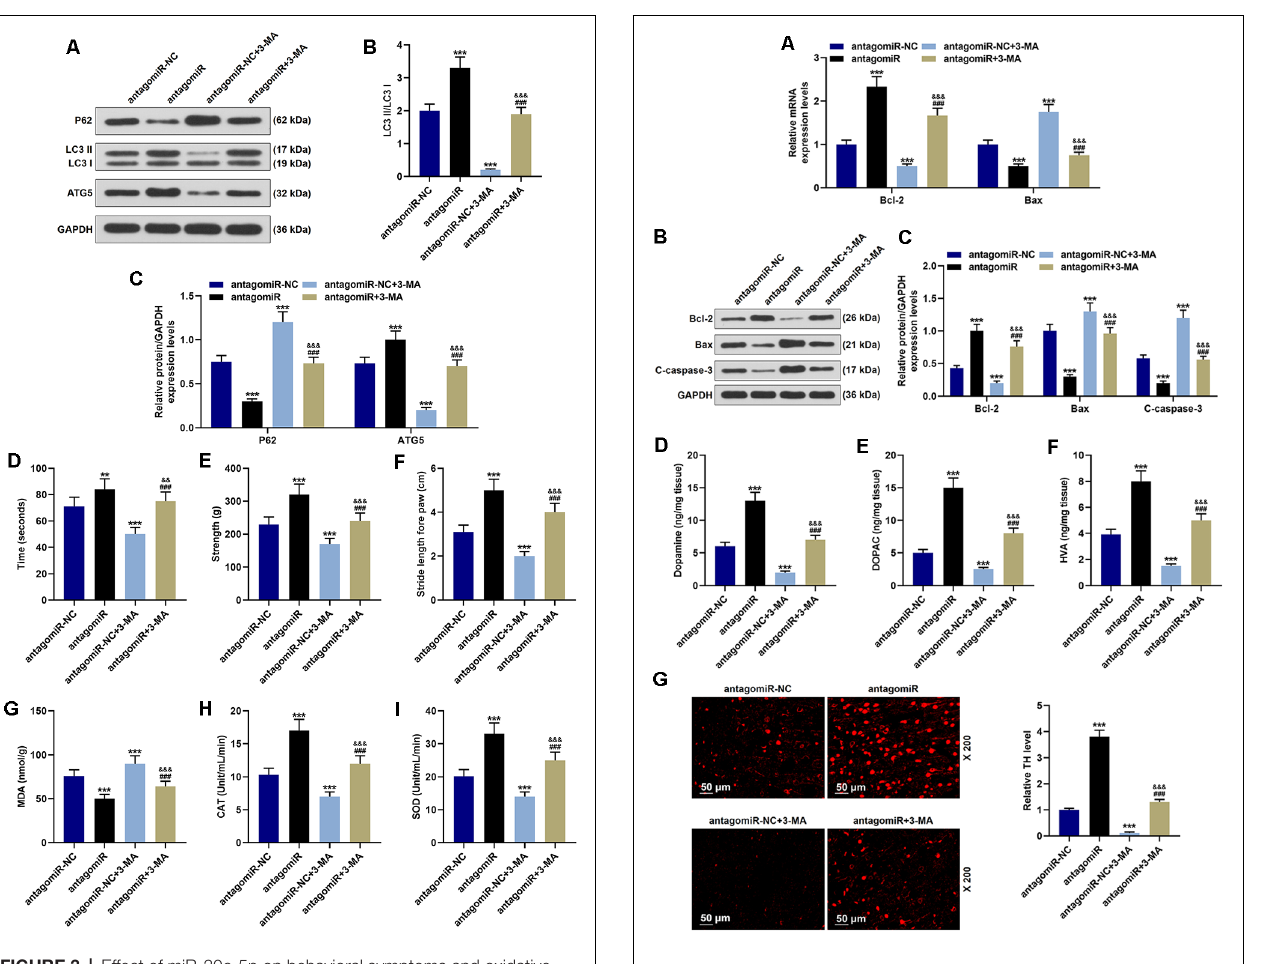
FIGURE 4 | Effects of miR-30c-5p and autophagy on apoptosis-related proteins, dopamine metabolic markers, and TH in PD mice. (A) Expressions of Bcl-2 and Bax were determined by qPCR. (B,C) Expressions of Bcl-2, Bax, and cleaved-caspase-3 (C-caspase-3) in brain tissues were assessed by Western blot. GAPDH served as an internal control. (D–F) Dopamine metabolic markers dopamine, DOPAC, and HVA in mice were detected using a Diode Array Detector. (G) The level of TH in the SNpc was determined by immunofluorescence. Scale bar = 50 µ m. 200 × . *** p < 0.001 vs. antagomiR-NC. ### p < 0.001 vs. antagomiR-NC +3-MA. &&& p < 0.001 vs.